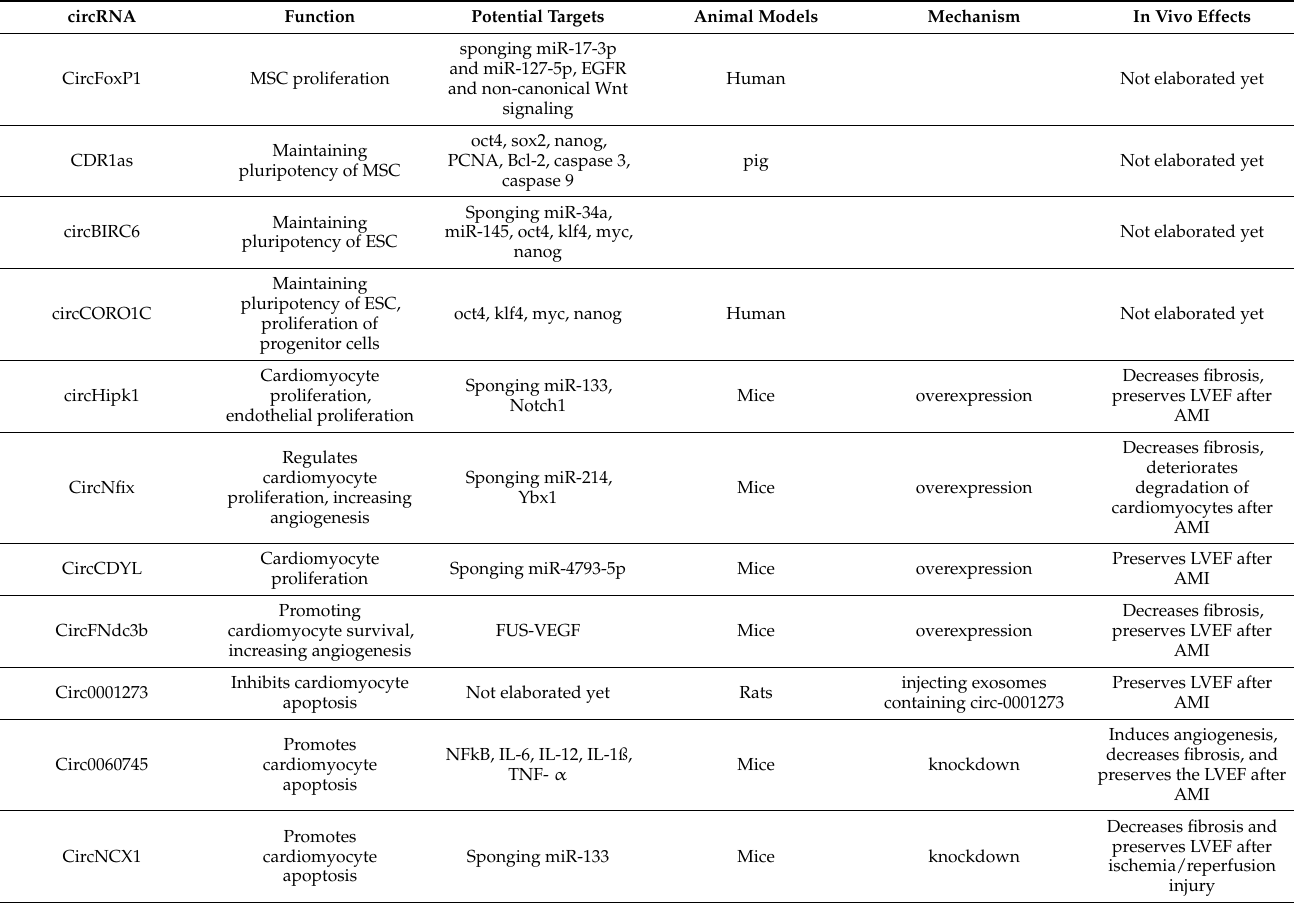
Table 3. Summary of circRNAs considered to be involved in stem cell regulation and cardiac